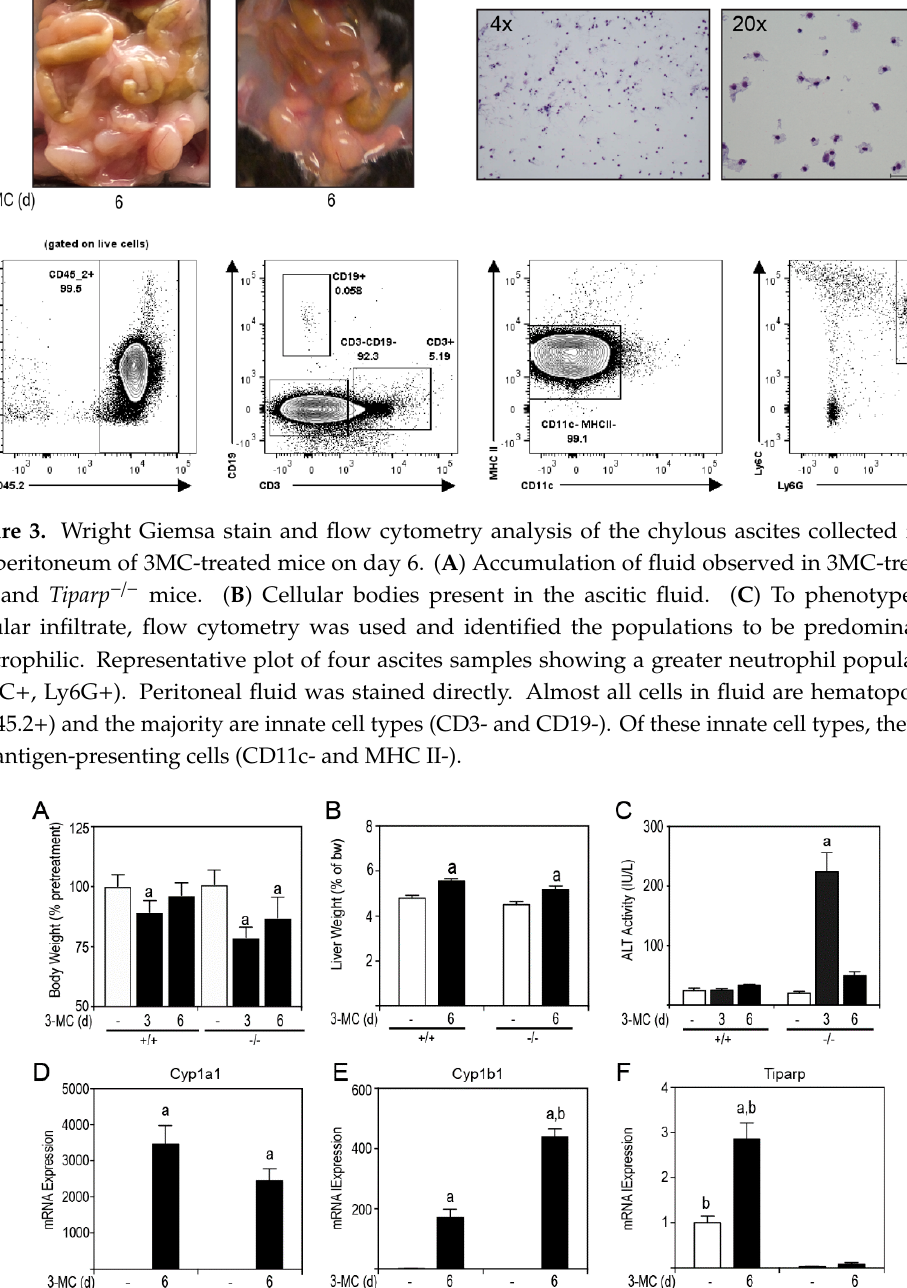
Figure 4. Six-day exposure to 100 mg/kg 3MC causes a transient increase in alanine aminotransferase (ALT) activity and increased hepatic Cyp1b1 but not Cyp1a1 expression levels. ( A ) Body weight. ( B ) Liver weight. ( C ) ALT activity levels. Gene expression levels of Cyp1a1 ( D ), Cyp1b1 ( E ), and Tiparp ( F ). Data represent the mean ± SEM; n = 3 for all genes. a p < 0.05 two-way ANOVA comparison between genotype-matched corn oil- and 3MC-treated mice and b p < 0.05 two-way ANOVA comparison between treatment-matched WT and Tiparp -/- mice followed by a Tukey’s post hoc test.